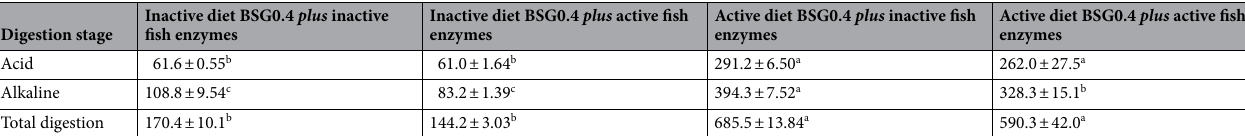
Table 4. Pentoses release (µg g −1 diet h −1 ) of BSG0.4 diet during the gastric, intestinal, and total in vitro digestion. Values presented as mean (n = 3) ± standard deviation (SD). Values in the same row with different subscripts are significantly different ( p < 0.05).